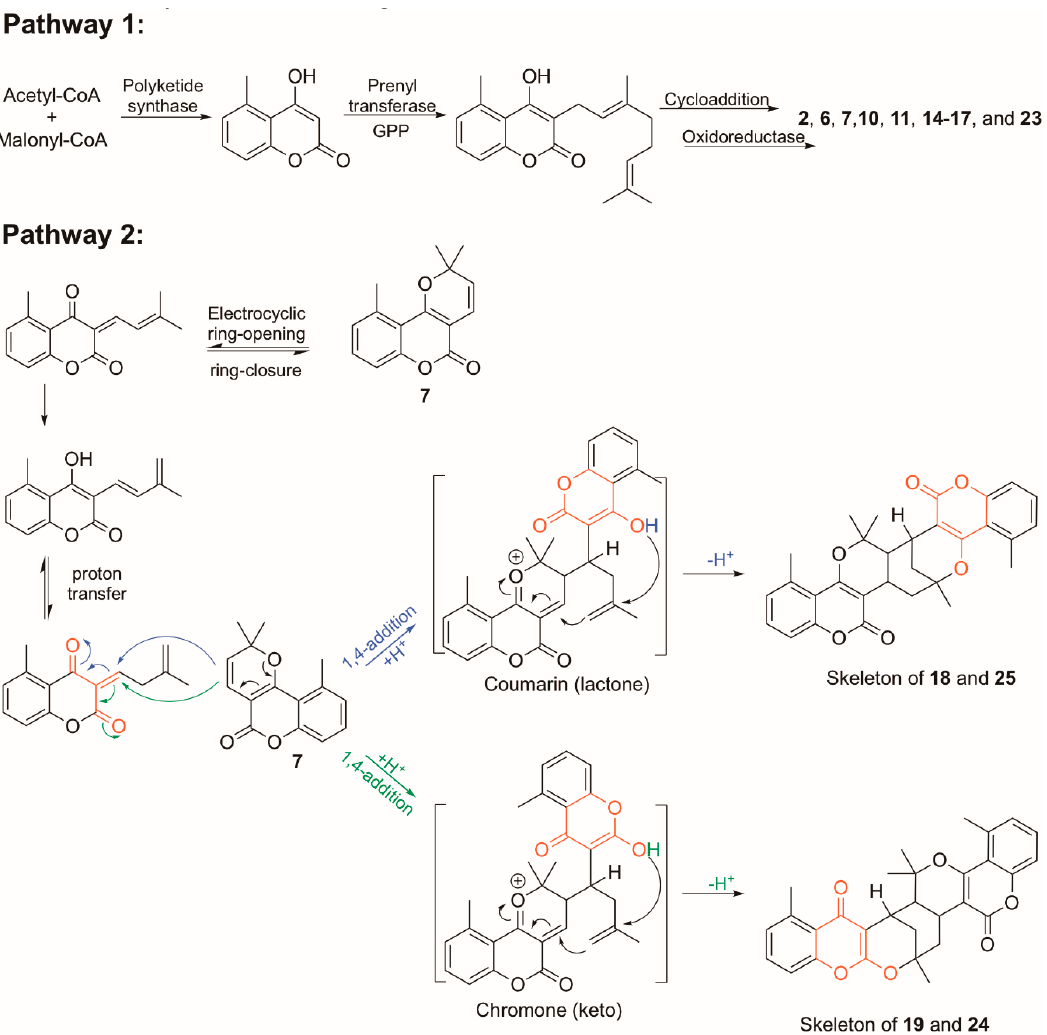
Figure 10. Possible biosynthetic pathway for the prenyl- and geranyl substituted coumarin derivatives isolated in this study.